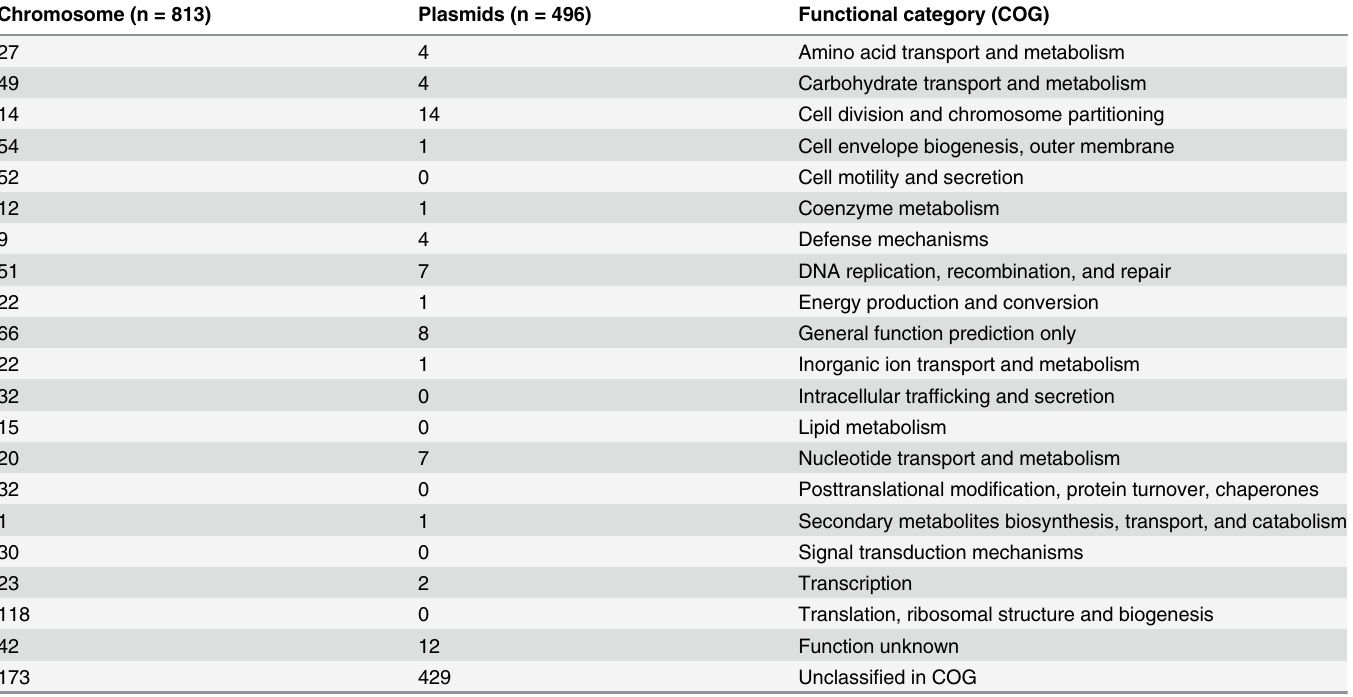
The best-hits per category from rpsblast against COG with a cutoff of E-value 0.01 are counted. Proteins with the best-hit falling into more than one category are counted as hit in each category which results in the addition of 51 hits, resulting in a total of 758 hits to de fi ned